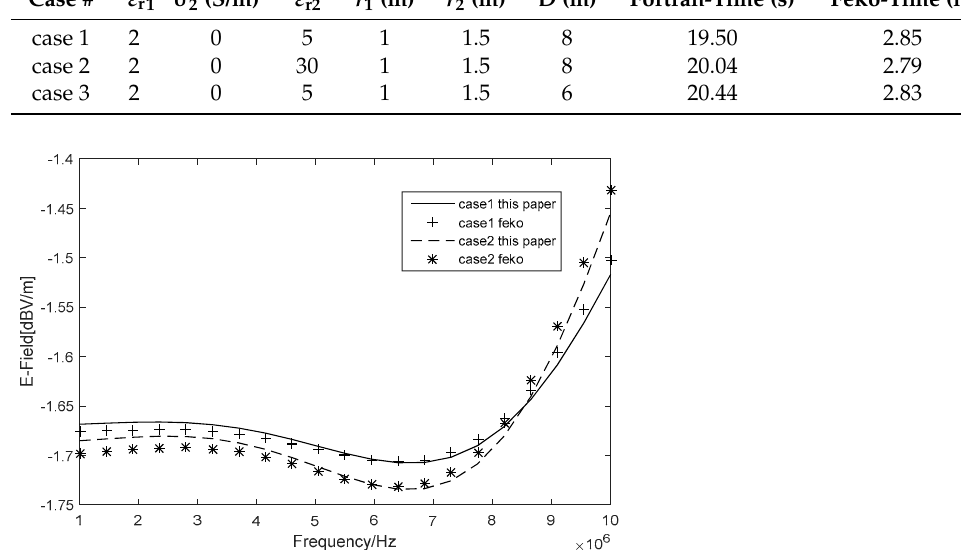
Figure 3. Electric field values with the frequency under different relative permittivities of the coating medium.